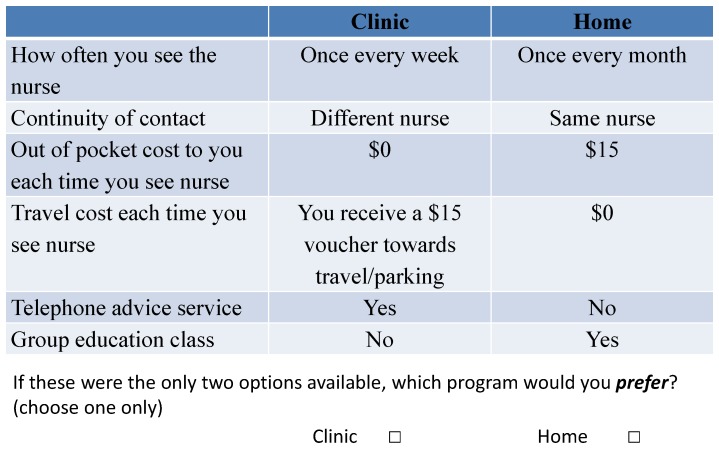
Sample choice set.